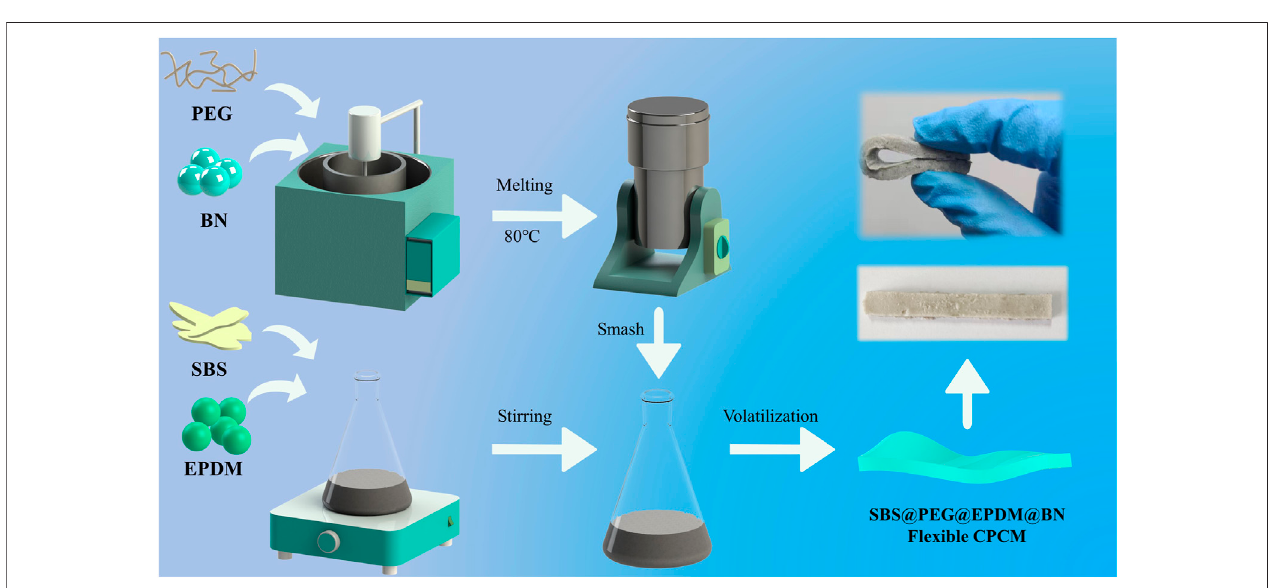
FIGURE 1 | The preparation process of SBS@PEG@EPDM@BN fl exible composite phase-change material